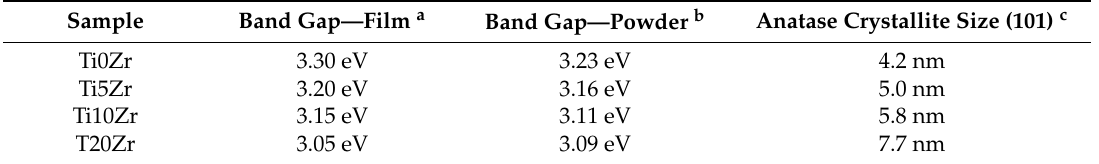
Table 2. Band gap and grain size values.